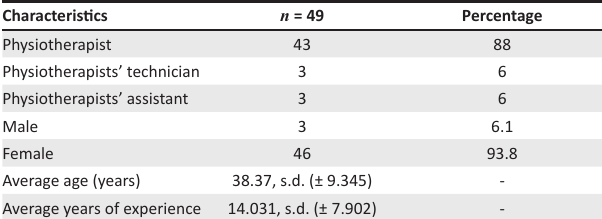
TABLE 1: Demographic characteristics of participants Characteristics